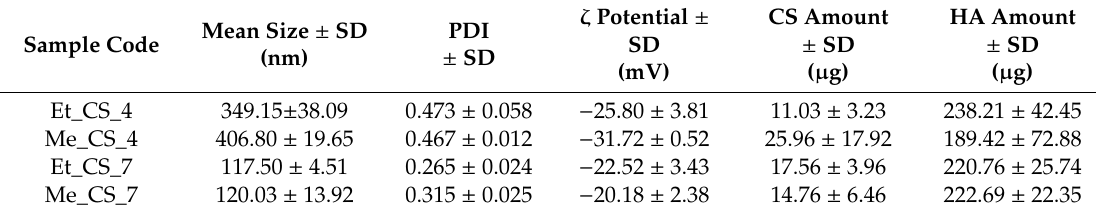
Table 2. Comparison of mean size, PDI and ζ potential and polymeric composition of di ff erent placebo HA / CS NPs batches prepared by adding Et or Me in CS